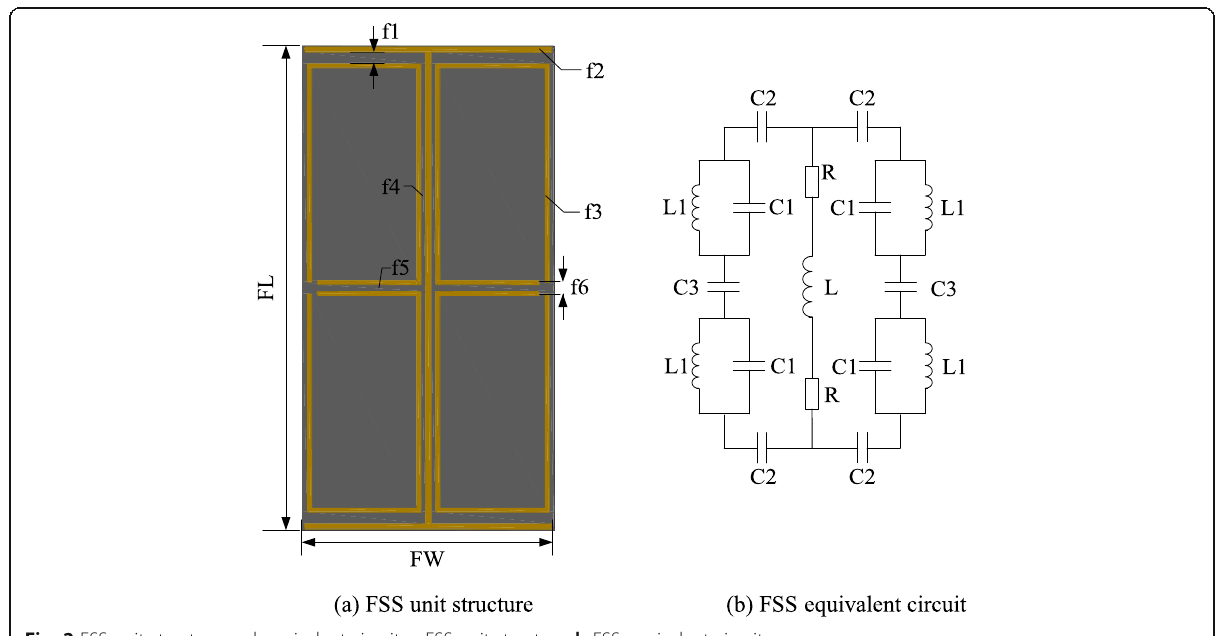
Fig. 2 FSS unit structure and equivalent circuit. a FSS unit structure. b FSS equivalent